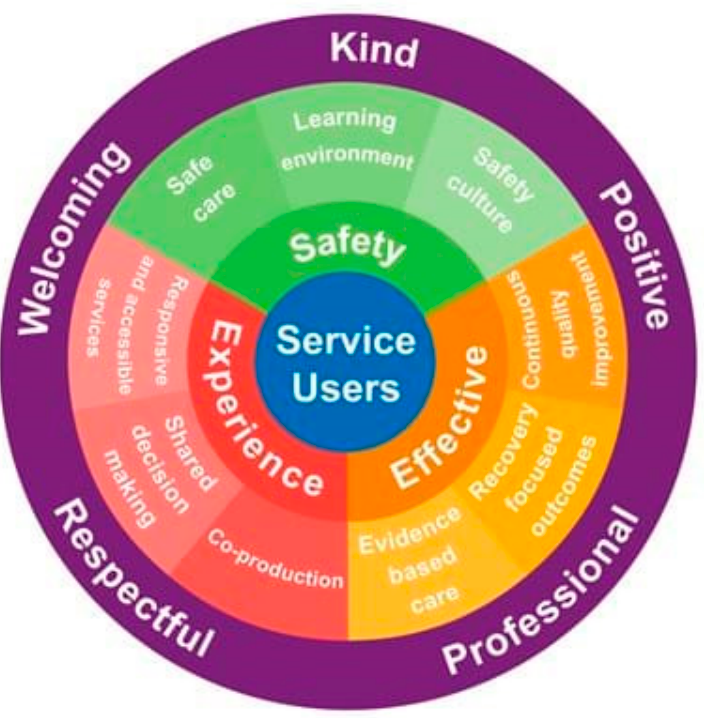
Figure 1. Values of the NHS Constitution [31].